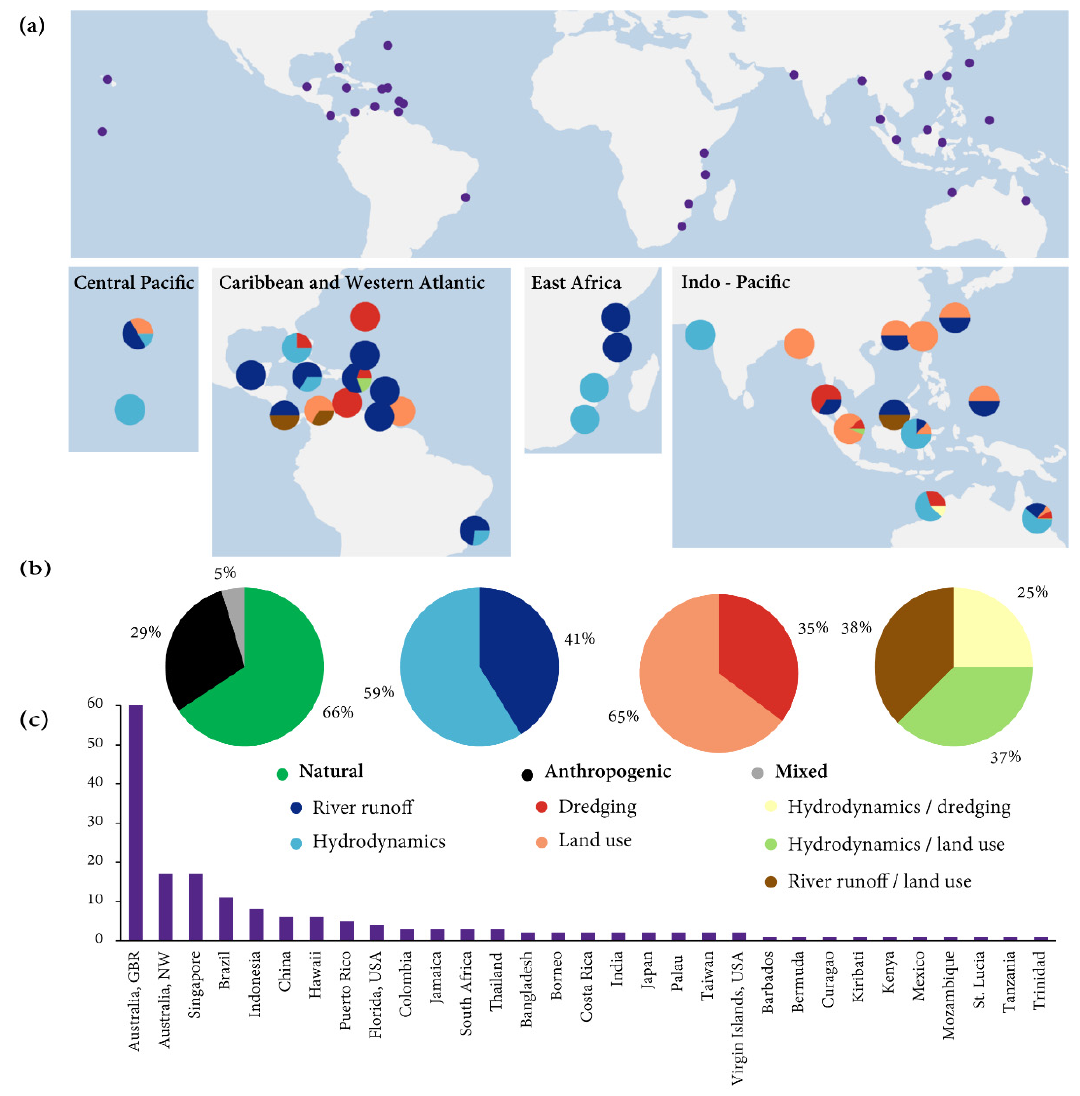
Figure 3. ( a ) Global distribution of the reviewed studies on turbid coral reefs. Colors in pie charts indicate the turbidity source described in the study. ( b ) Global percentage of turbidity source of studies conducted in natural (hydrodynamics n = 67, river runoff n = 47), anthropogenic (dredging n = 18, land use n = 33) and mixed (hydrodynamics/dredging n = 2, hydrodynamics/land use n = 3, river runoff/land use n = 3) environments. ( c ) Number of papers published in each location ( n = 31). See Table S1 for details of studies and link to references.